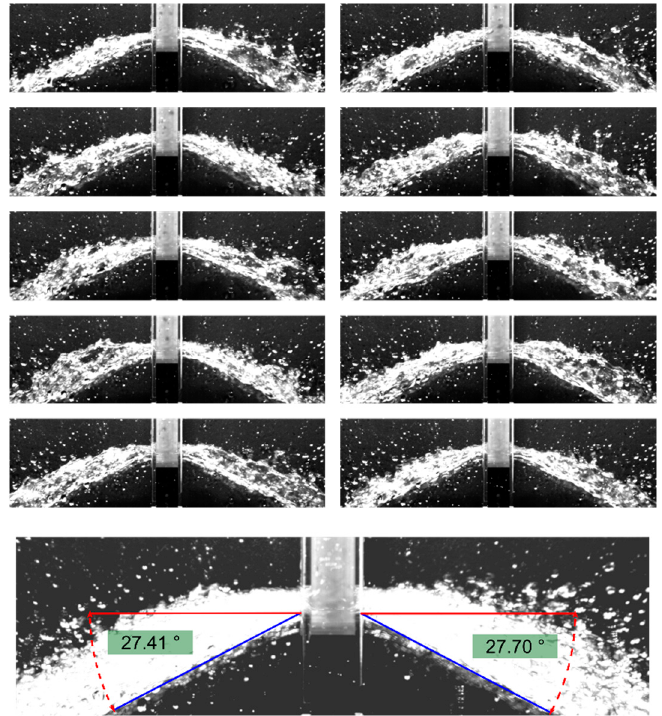
Figure 7. The top panels show photographs of water jets discharged (ejected) from the type B NIP taken at 0.5 s intervals. The bottom panel shows the superposition of the ten photographs above it and also shows the angles formed between the jets inferior contour (blue) and the line perpendicular to the ports (red).